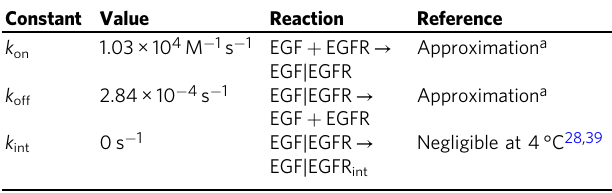
Table 3 EGF-EGFR kinetic rate parameters at 4 °C Constant